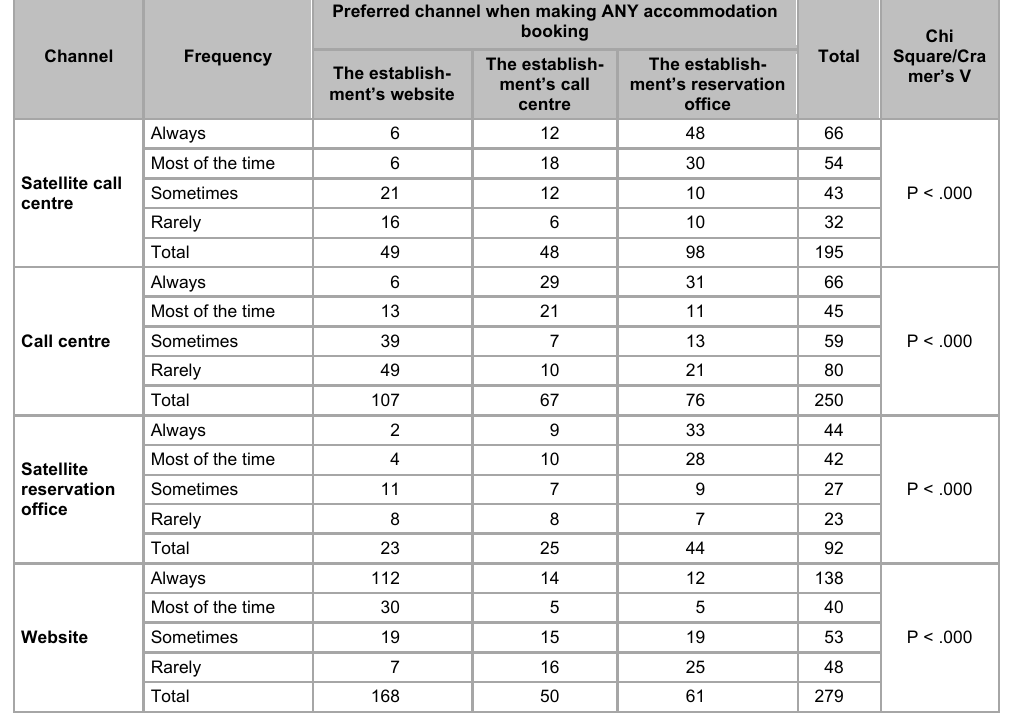
Table 10 Frequency of use and preferred channel when making ANY accommodation